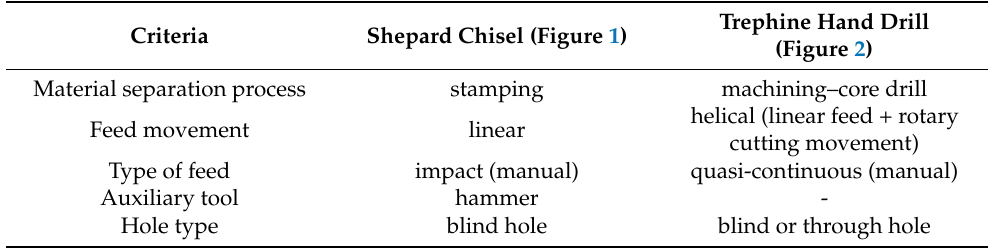
Table 1. Differences in process characteristics of the used tools.